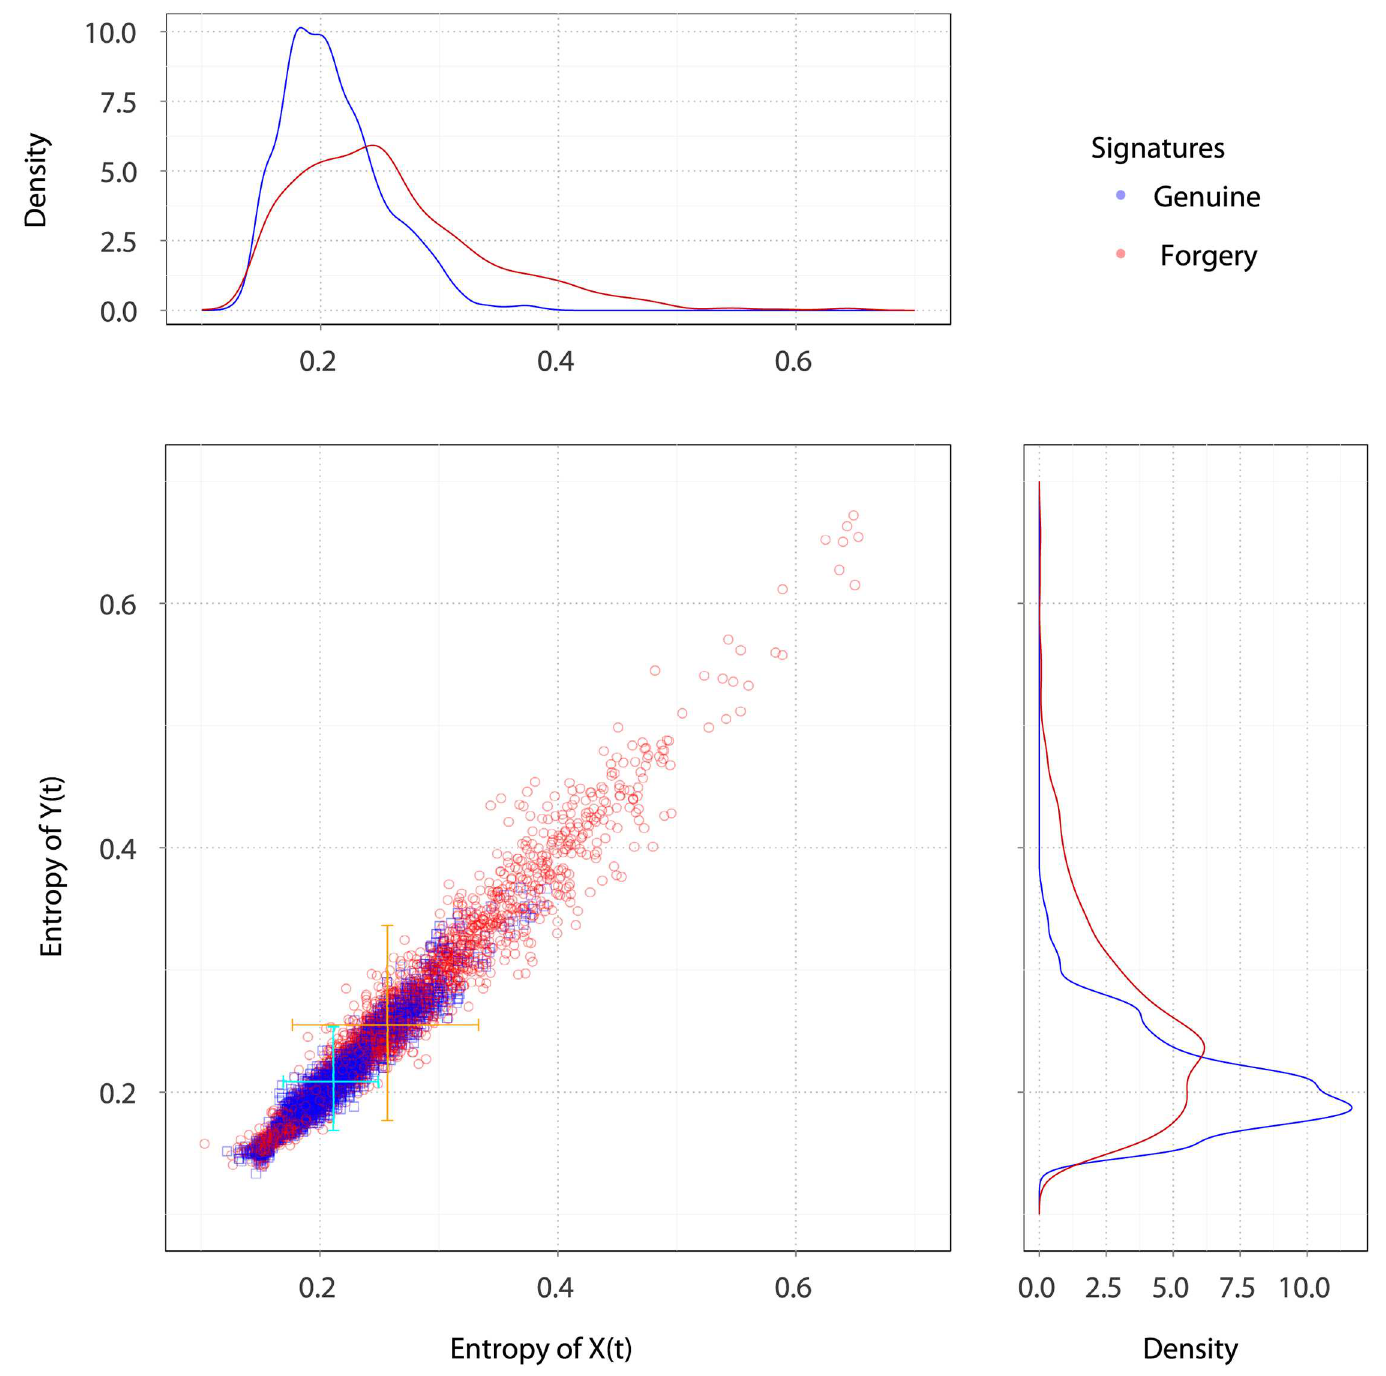
Fig 3. Scatter plot with marginal kernel density estimatesof entropy quantifiers in both trajectorycoordinates time series X and Y. Genuine(blue) and skilledforgery signatures(red points), 100 subjects. Marginal kernel densitiesdepict the distributionof entropy quantifiersalong both axes.